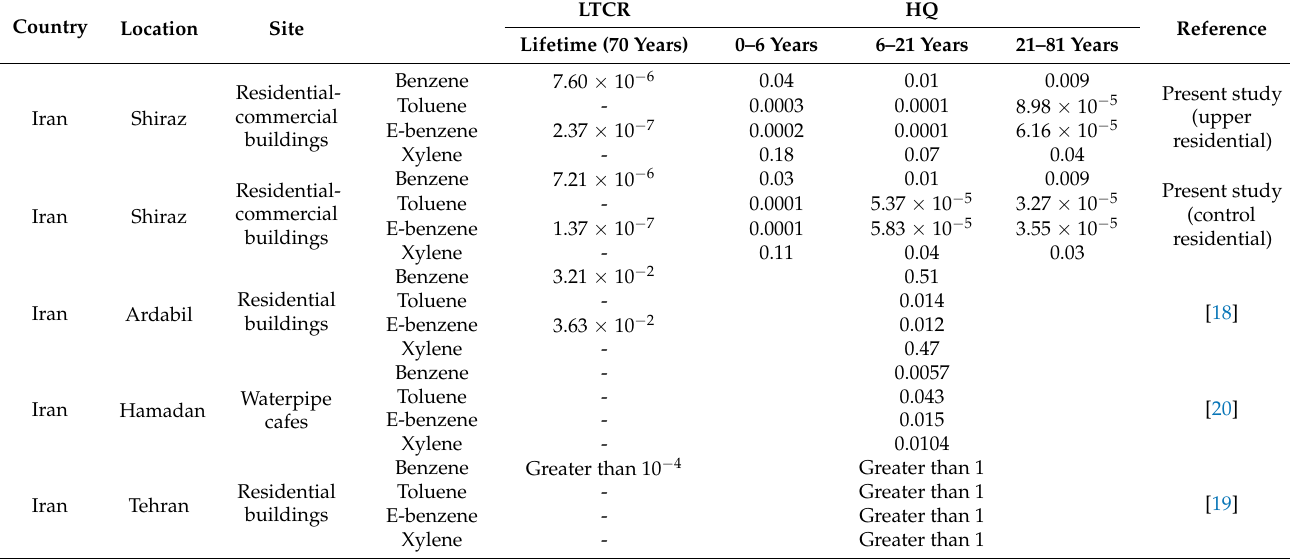
Table 5. Comparing the results of calculations for the carcinogenicity and non-carcinogenicity risk assessment of BTEX compounds in the present study and other